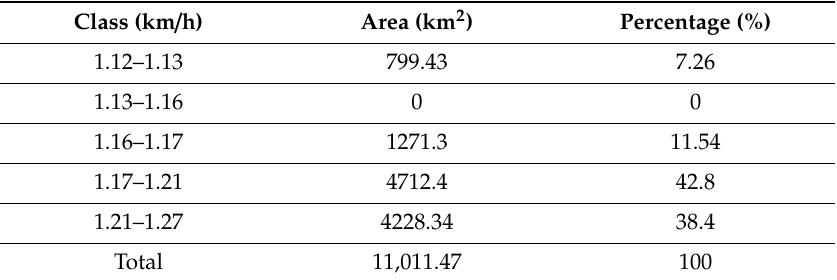
Table 18. Runo ff speed for Al-Shamal train pathway in Al-Qurayyat city in